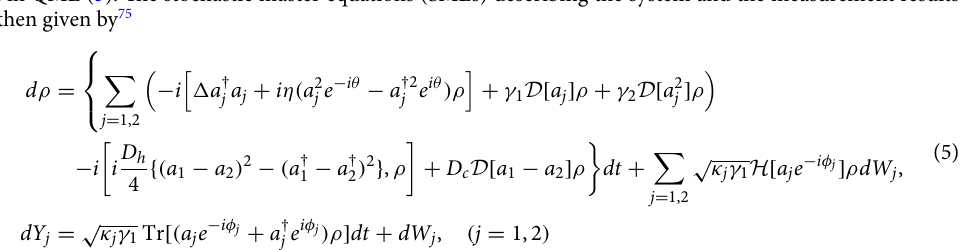
50 . ( c , d , e , f ) Time evolution of the = p 1 p 2 x 1 x 2 , ( d ) , ( e ) , and ( f ) . (cid:31) (cid:30) (cid:31) (cid:30) (cid:31) (cid:30) (cid:31) (cid:30) 0.3 , 0.6, γ 1 0.4, γ 2 0.1, θ π , η = = − = = = 1, 2 . In ( f ), the black 0 and κ 0.25 for both j j = j = =